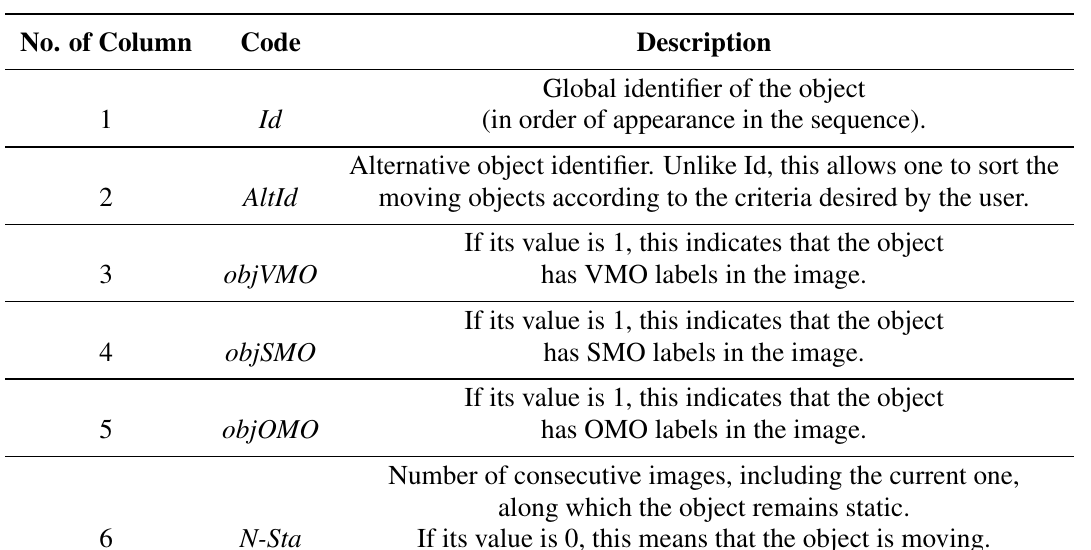
Table 2. Fields in